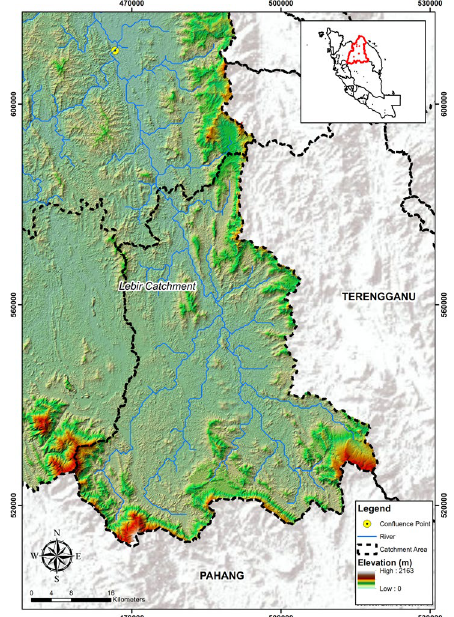
Figure 2. DEM map of Sungai Lebir catchment area